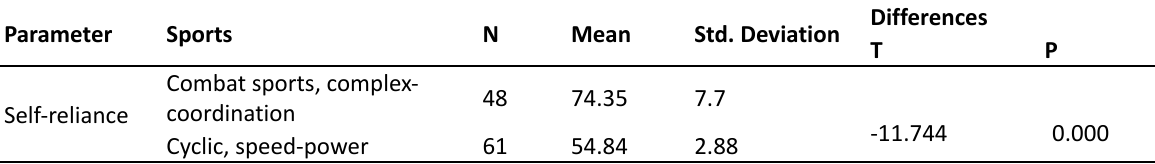
Table 1. Features of the manifestation of self-reliance from representatives of combat sports and complex-coordination sports Parameter Self-reliance Table 2. Features of self-reliance manifestation of athletes of cyclical and speed-strength sports Parameter Self-reliance Table 3 . Comparative analysis of self-reliance in athletes of different sports Parameter